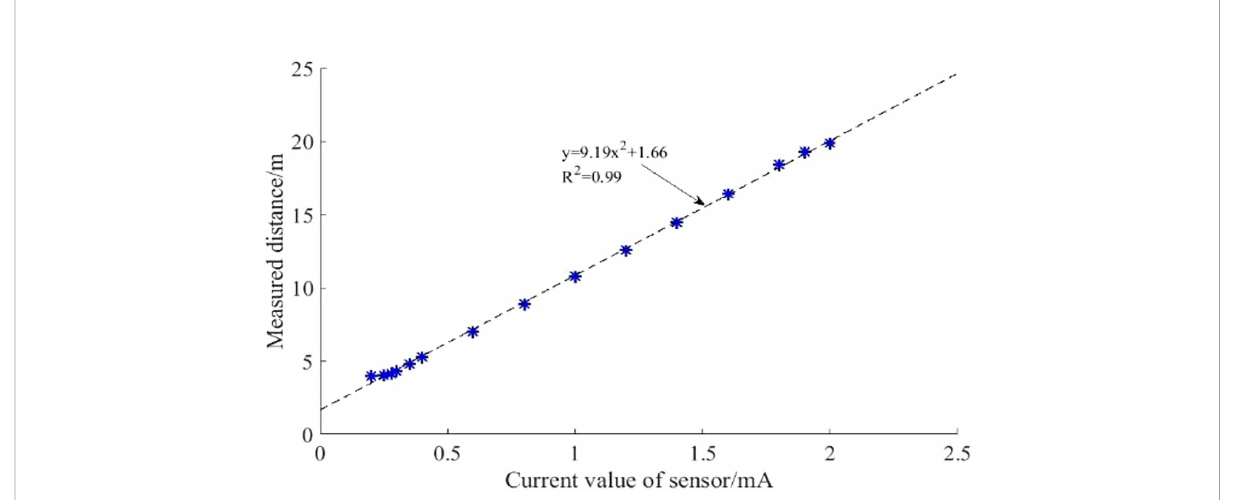
FIGURE 10 Wheat canopy detection test by ultrasonic sensor. The sensor current increases with the increase of measuring distance, with good linear correlation, and the correlation coef fi cient reaches 0.99. Symbol “ * ” represent distance detection values corresponding to different voltages.